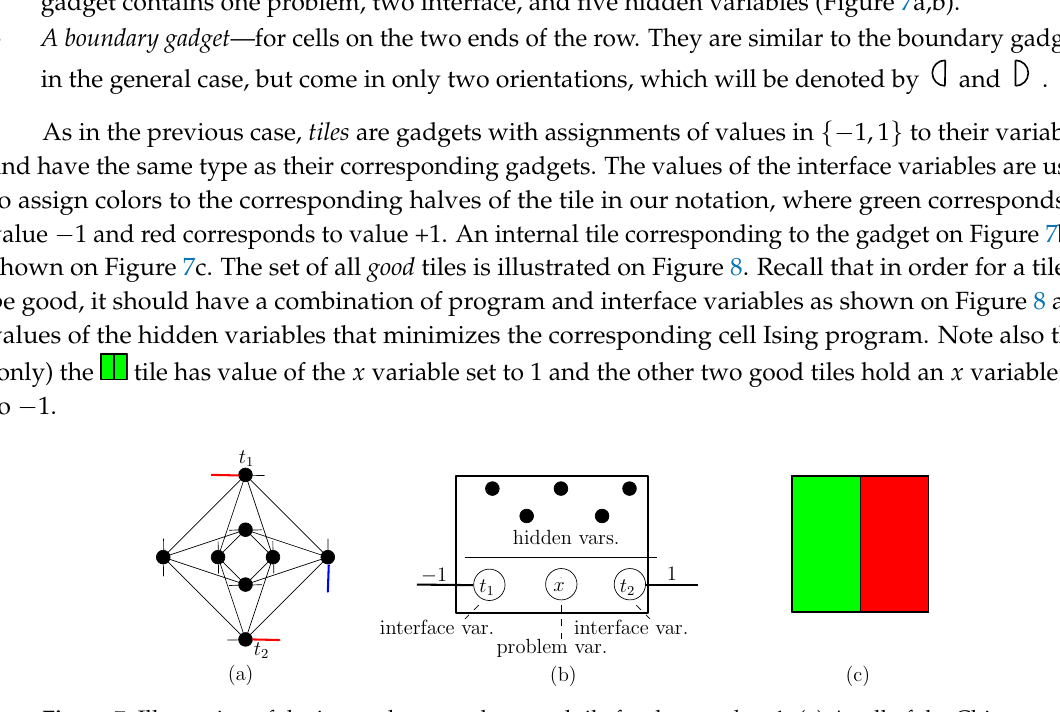
Figure 7. Illustration of the internal type gadgets and tile for the case k = 1. ( a ) A cell of the Chimera graph. Short lines indicate the couplers connecting to the neighboring cells (some may be missing for boundary cells). ( b ) The logical structure of the the corresponding internal gadget. There are two edges (couplers) shown in red (thicker line in b&w) in ( a ) with weights (in he example) − 1 and 1 connecting it to the neighboring cells in the row. The coupler shown in blue, in combination with the red coupler on top, is used in the gadget discussed in Section 7.2. ( c ) The corresponding tile as used in our embedding illustrations, with red color for +1 and green for − 1 type